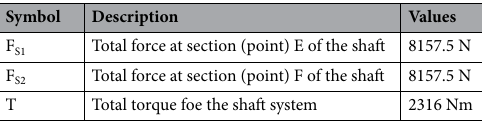
Table 7. Parameters for static analysis.